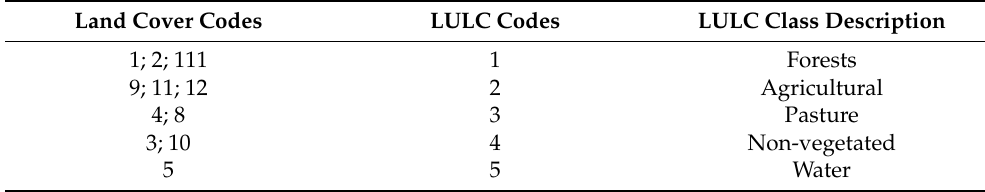
Table 5. Land cover and LULC codes